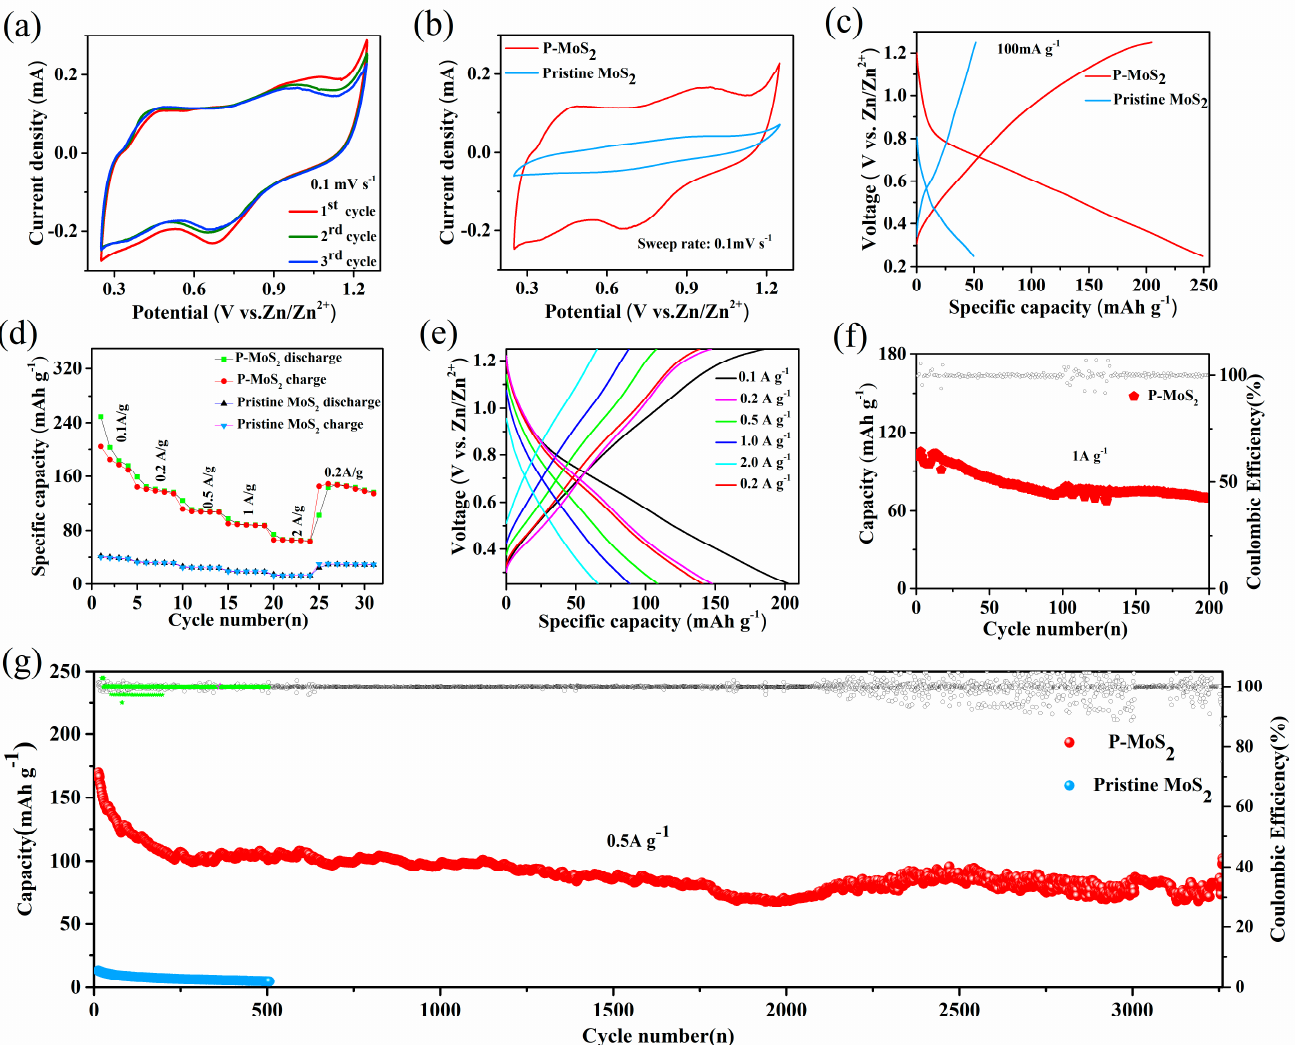
Figure 5. Electrochemical performance of P-MoS 2 and pristine MoS 2 ( a ) CV curves at 0.1 mV s − 1 . ( b ) CV at 0.1 mV s − 1 rate of P-MoS 2 and Pristine MoS 2. ( c ) Discharge/charge curves at 0.1 A g − 1 . ( d ) Rate performance. ( e ) First cycle capacity at different cycles. ( f ) Two hundred cycling stability at 1 A g − 1 . ( g ) Long-term cycling stability at 0.5 A g − 1 . P-MoS 2 maintains a capacity of 102 mAh g − 1 after 3260 cycles, achieving capacity re-